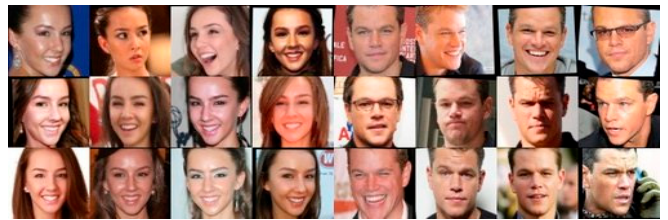
Figure 5. Face images in FaceScrub dataset.